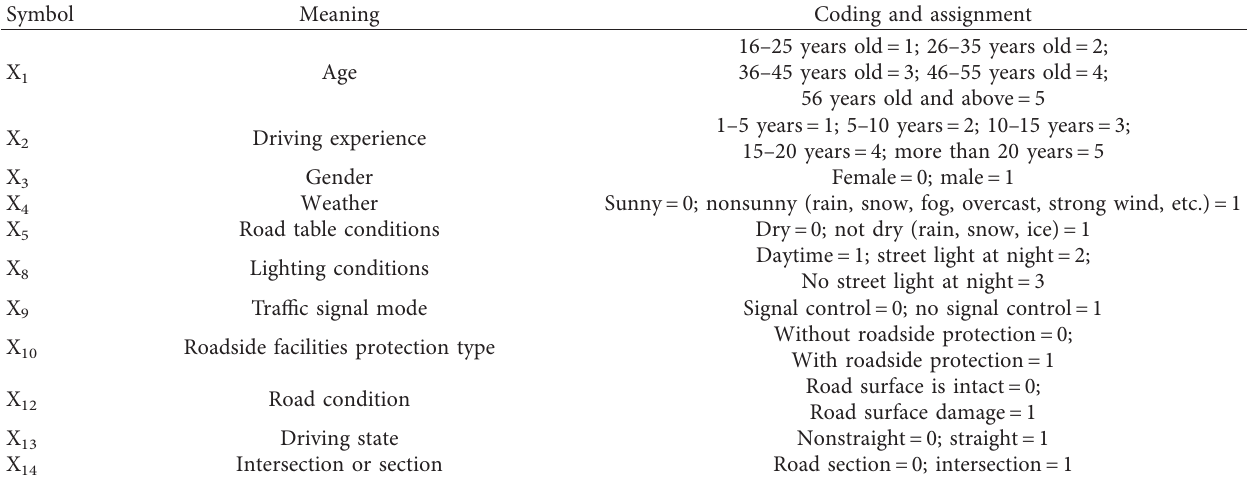
Table 3: Coding and meaning of independent